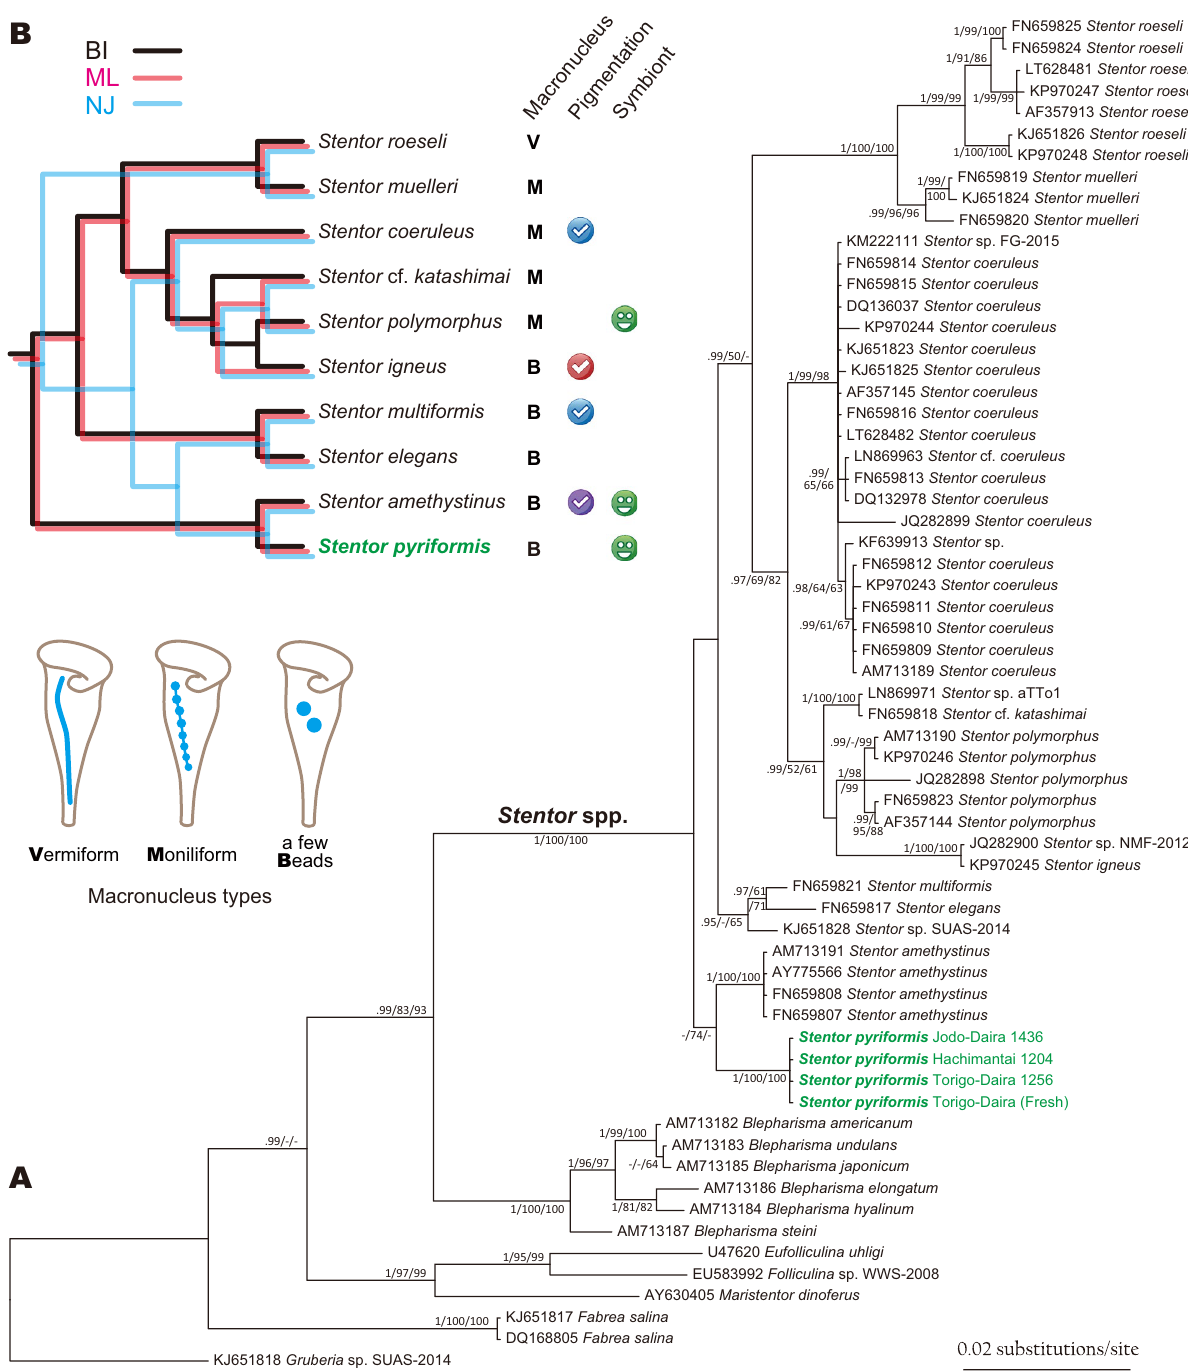
and glycogen stains reddish brown (Table 2). The granules in the cytoplasm of S. pyriformis stained reddish brown with Lugol’s solution (Fig. 4A), suggesting that these granules are composed of α-1,4-linked glucans with high number of α-1,6-linked branch points, either amylopectin-rich starch or glycogen. The pyrenoid of Chlorella spp. is surrounded by a starch sheath of two large plates 35 . As shown in Fig. 4F,G, the image contrast